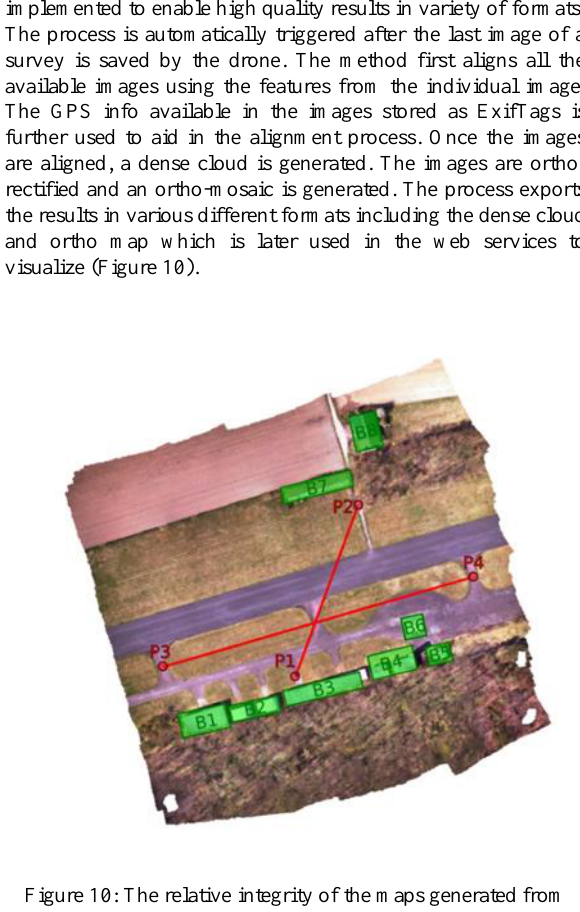
Figure 10: The relative integrity of the maps generated from SLAM in reference to the PhotoScan after registration